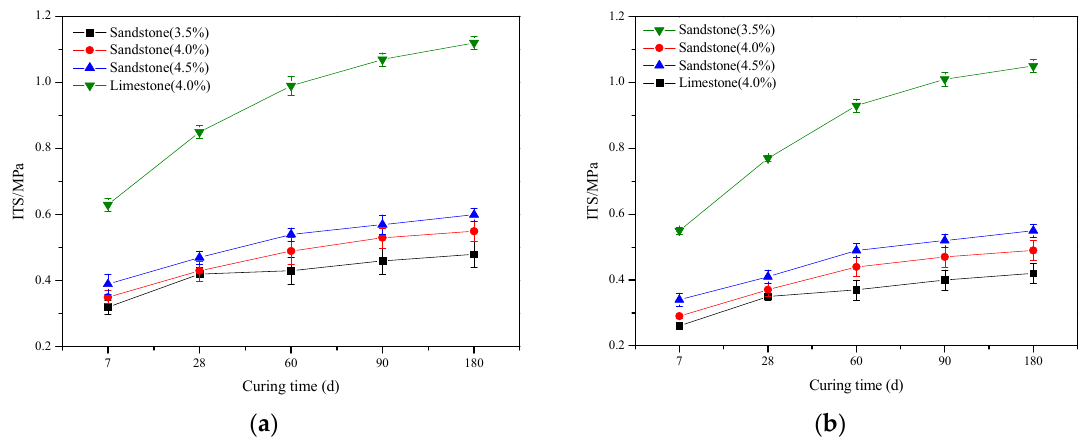
Figure 6. Relationship between the ITS and curing time. ( a ) Dry state ( b ) Water-saturated stat.